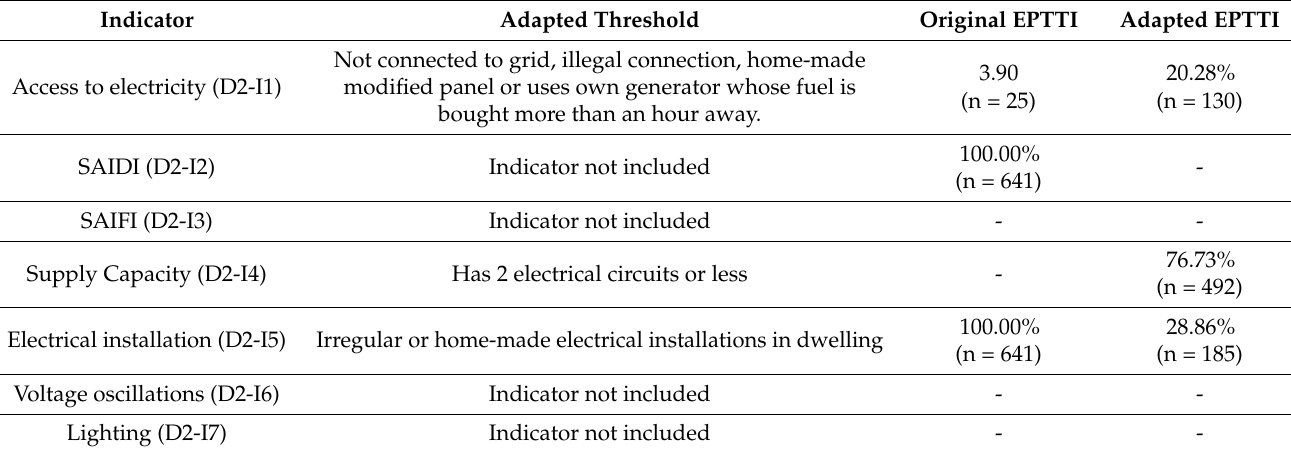
Table 6. Comparison of D2’s indicators between original and adapted